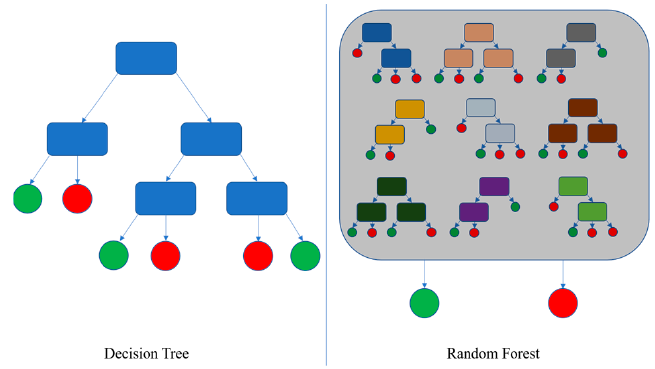
Figure 2. A comparison of DT and RF Figure 2 . A comparison of DT and RF [18].